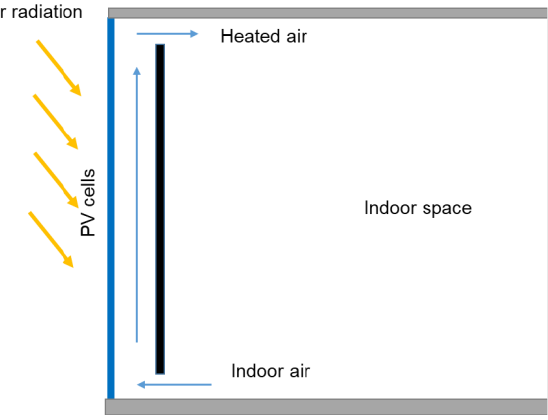
Figure 16. Scheme of ventilated active PV facade.